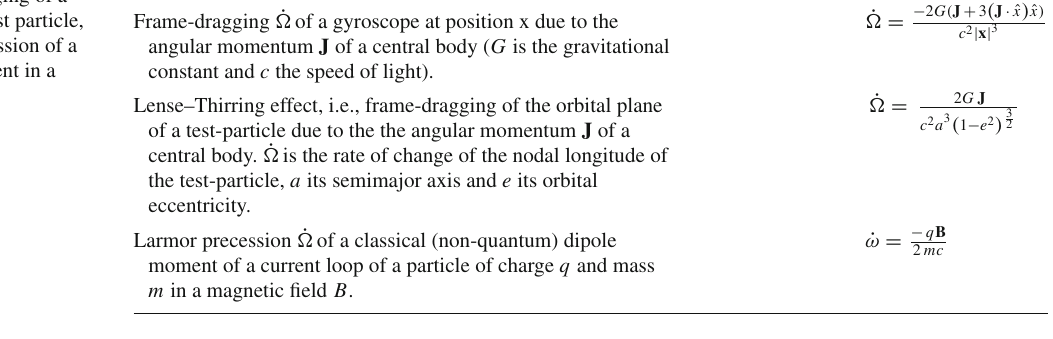
Table 2 Frame-dragging of a gyroscope and of a test particle, Frame-dragging ˙ (cid:2) of a gyroscope at position x due to the and the Larmor precession of a angular momentum J of a central body ( G is the gravitational classical dipole moment in a constant and c the speed of light). magnetic field B Lense–Thirring effect, i.e., frame-dragging of the orbital plane of a test-particle due to the the angular momentum J of a central body. ˙ (cid:2) is the rate of change of the nodal longitude of the test-particle, a its semimajor axis and e its orbital eccentricity. moment of a current loop of a particle of charge q and mass m in a magnetic field B .